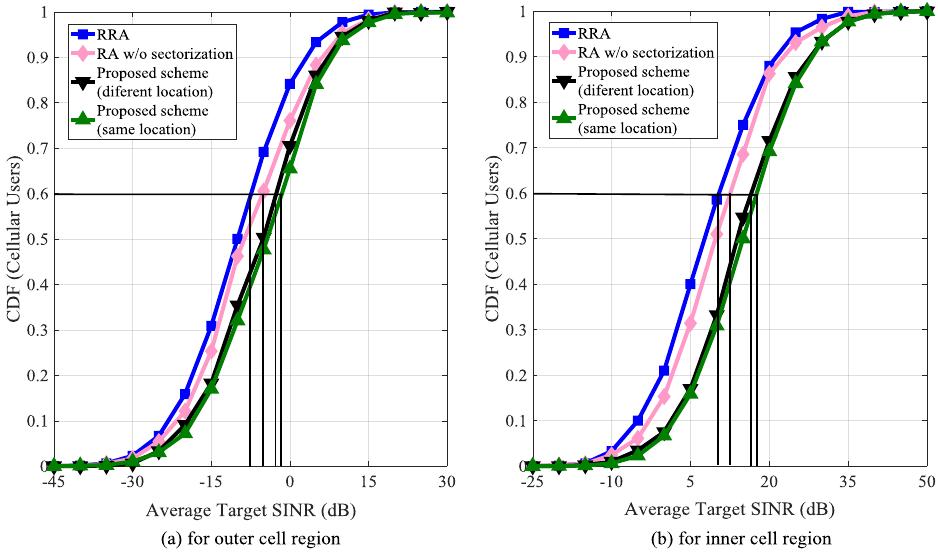
Figure 7. Average target SINR vs. CDF for cellular users with the same and different locations of D2D Tx and Rx, ( a ) outer cell region, ( b ) inner cell region.